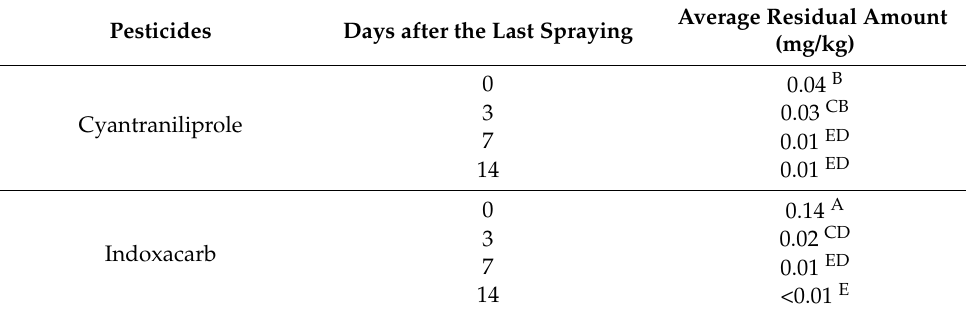
Average Residual Amount